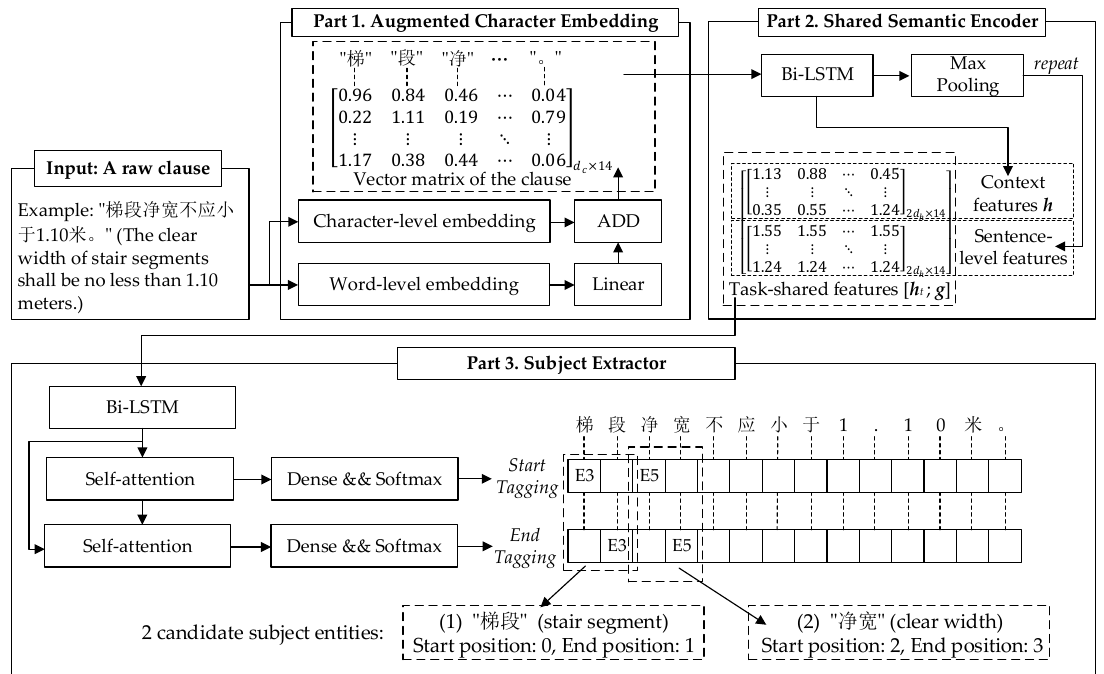
Figure 3. The extraction of candidate subject entities. In this figure, the clause “The clear width of stair segments shall be no less than 1.10 m (in Chinese: 梯 段 净 宽 不 应 小 于 1.10 米 ”), with a length of n = 14, is taken as an